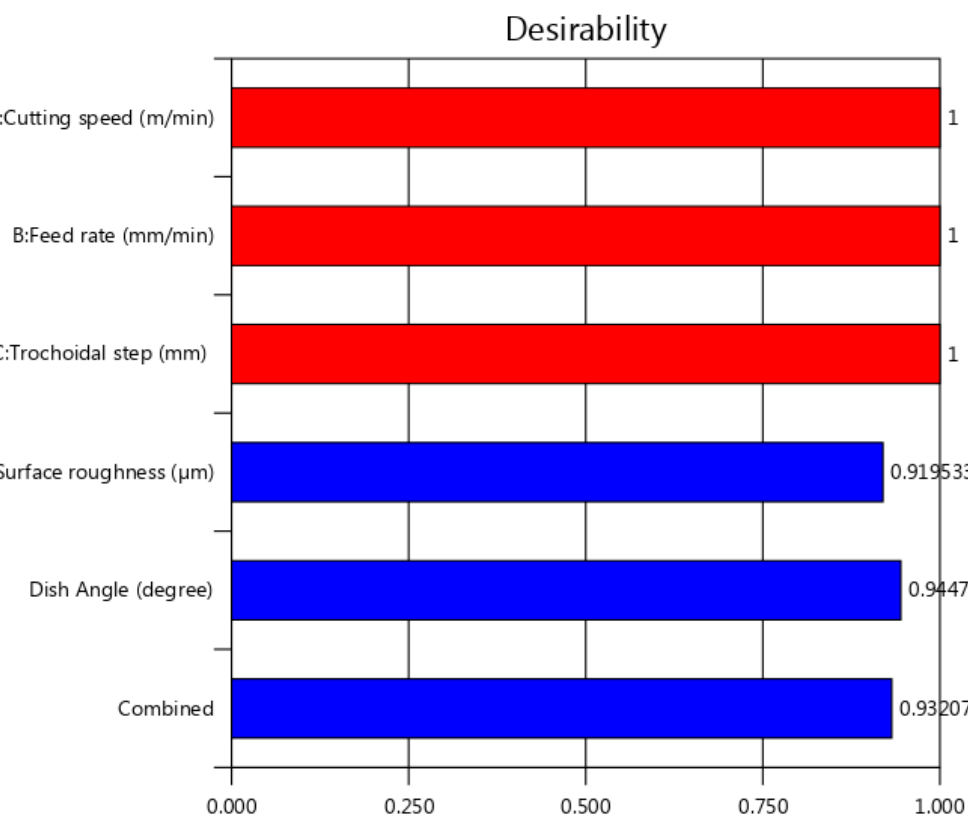
Figure 13. Two-dimensional (2D) composite desirability histogram plot. Table 7. Optimum parameter level and output response.